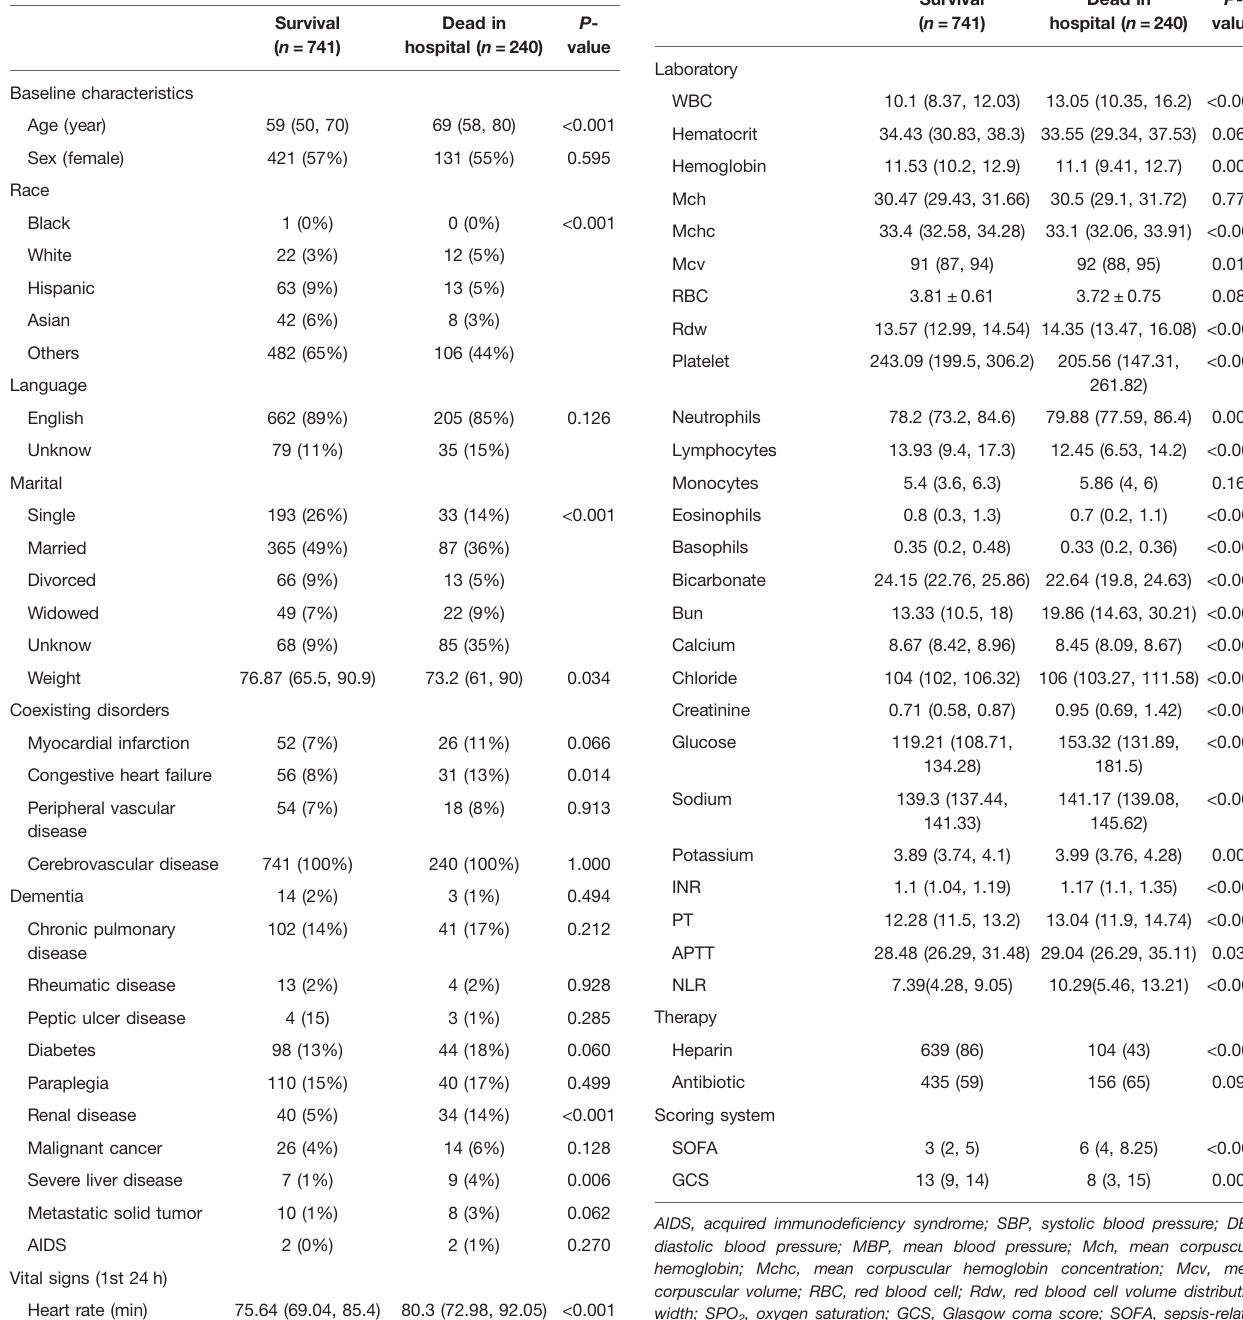
outcomes reported in a case study (19), Satoh et al. found that patients presenting with neurogenic pulmonary edema had lower bicarbonate concentrations (20). In addition, Stephan et al. found that one in fi ve patients had abnormally low bicarbonate levels on admission and a poor prognosis (21).